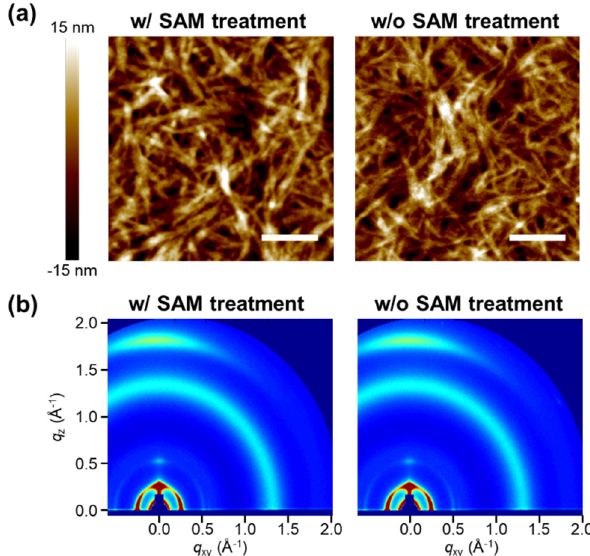
Figure 2. Microstructural characterization of P4TNTz-2F:PC 71 BM blend films. Left: blend film on NPC70-OH/ZnO (with SAM treatment). Right: blend film on ZnO (without SAM treatment). ( a ) AFM height images. Scale bar: 500 nm. Root-mean-square roughnesses are 4.22 nm and 4.16 nm, respectively. ( b ) 2D GIWAXS images.